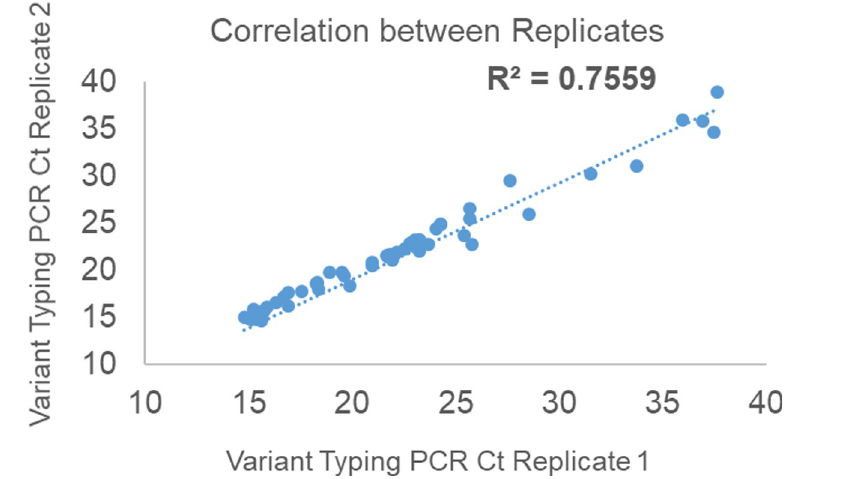
Fig 4. Correlation between replicate Ct values of 53 samples analyzed by Variant II PCR.